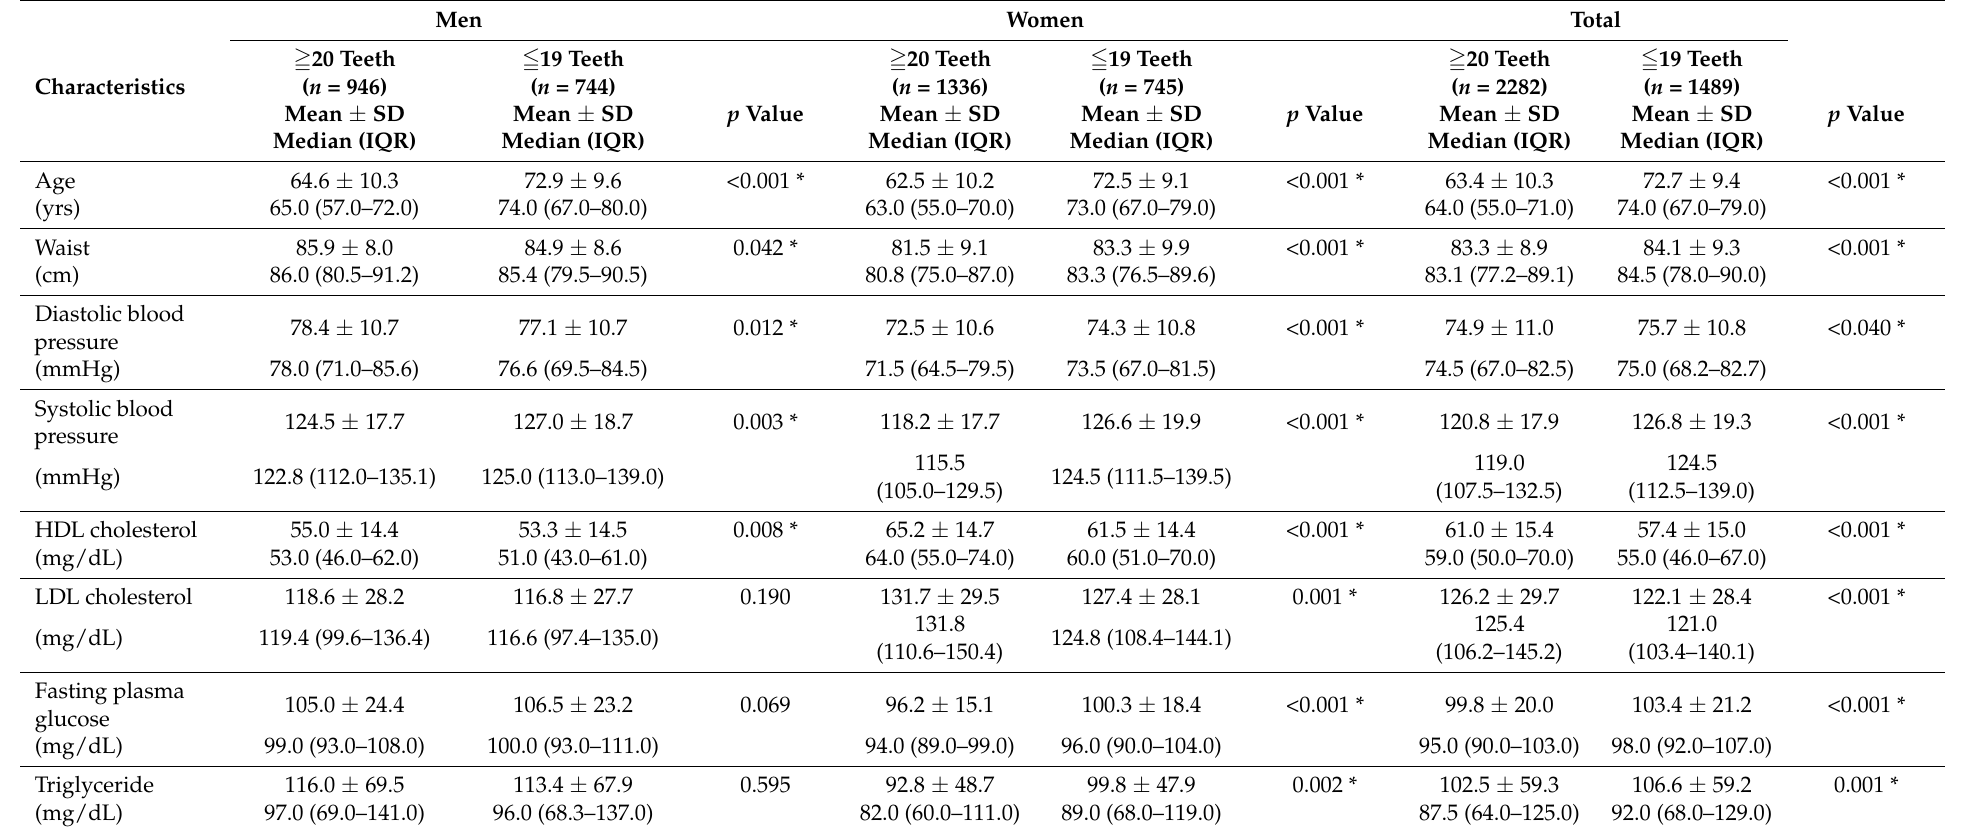
Table 1. Characteristics of subjects according to the number of teeth ( (cid:61) 20 teeth or (cid:53) 19